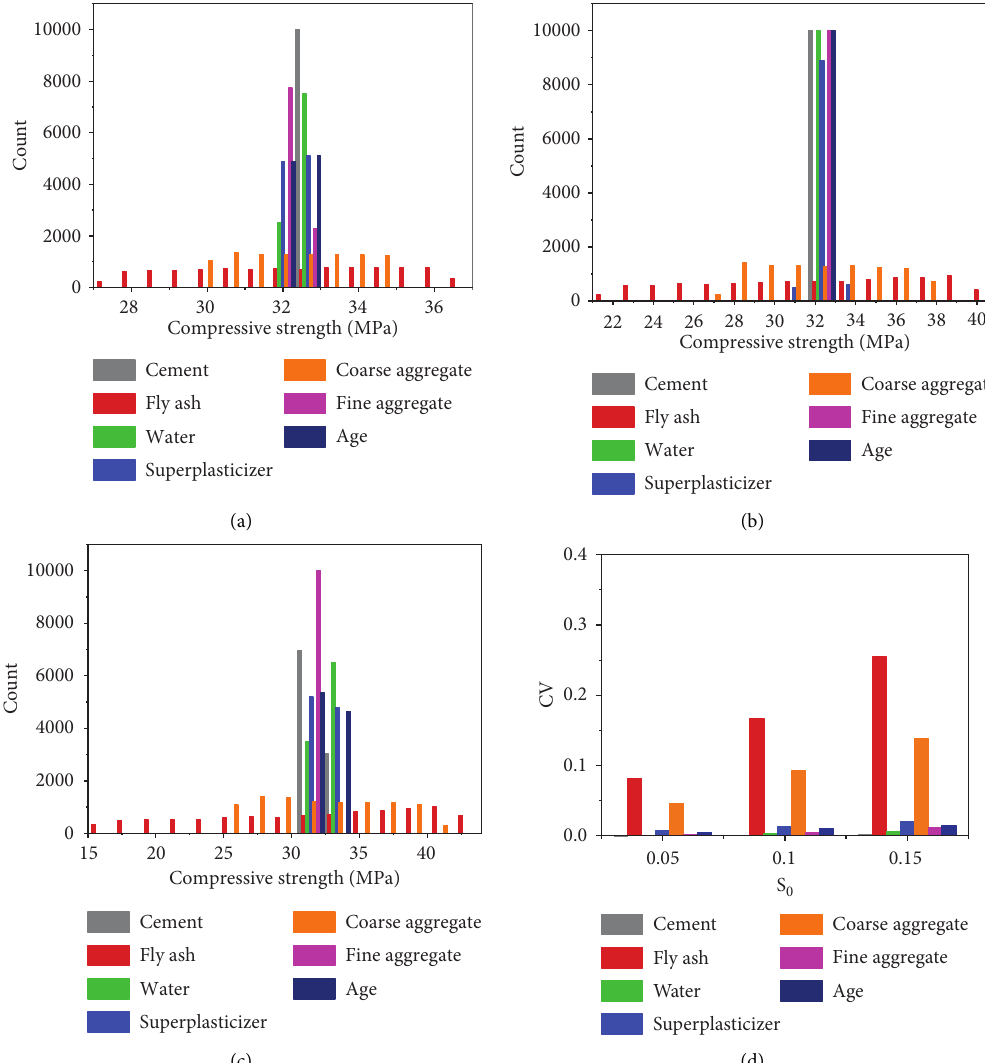
Figure 9: Distribution of the predicted values of compressive strength at different random degrees. (a) S (d)